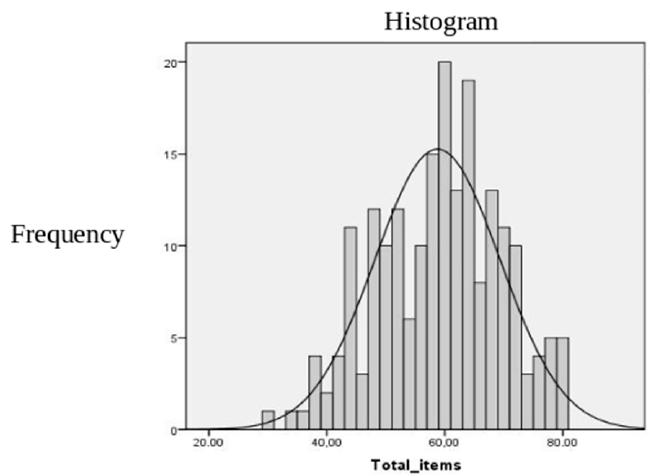
Figure 2. Frequency distribution of the variable total_items.